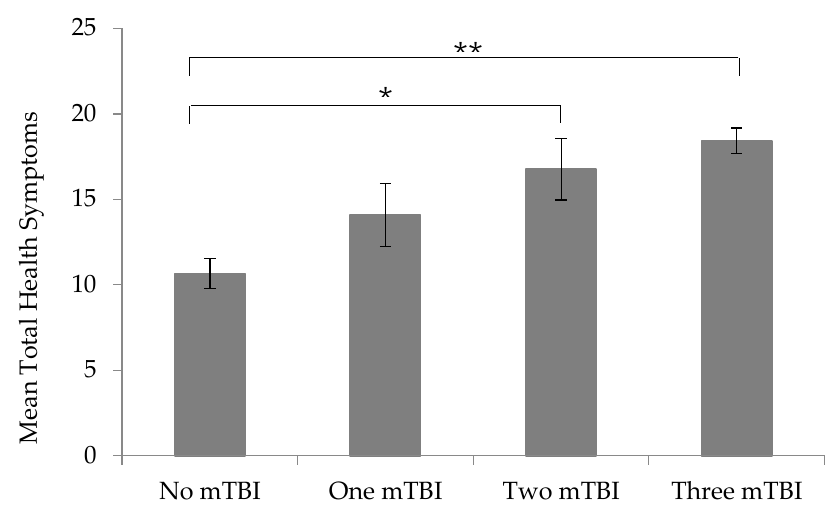
Figure 1. Mean total health symptoms by mild traumatic brain injury (mTBI) group. Error bars represent standard error. * p = 0.007. ** p < 0.001.